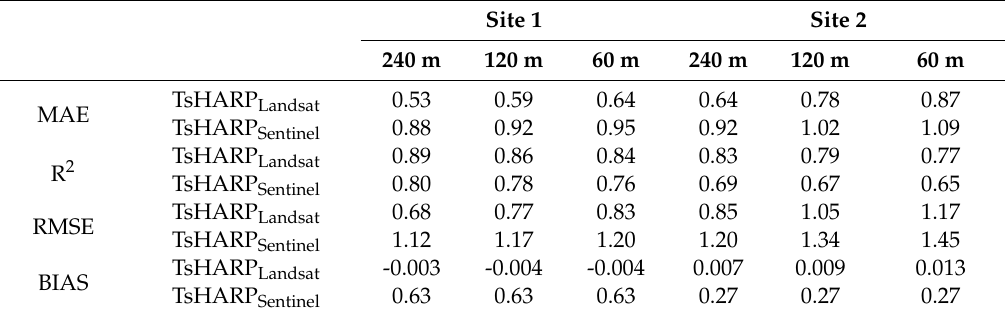
Table3. Statisticsofthedisaggregatedthermalmapsincomparisonwiththereferencedthermalimagery. Site 1 Site